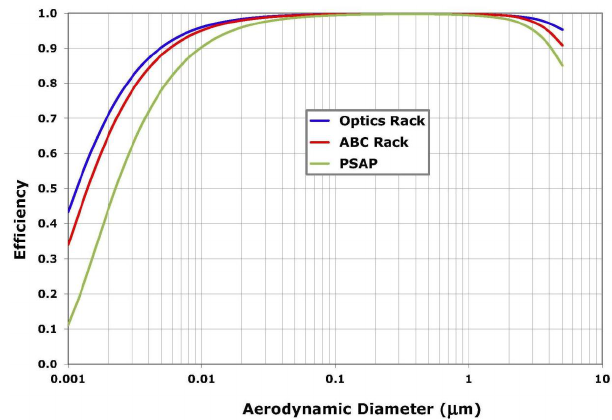
Fig. 2. Particle transmission efficiency through the aerosol sample lines between the main inlet and the Optics and ABC racks (calculated using Paul A. Baron’s aerosol calculator spreadsheet, AEROCALC.XLS). Curves represent the combined effects of gravitational, inertial and diffusional losses in a turbulent flow environment.